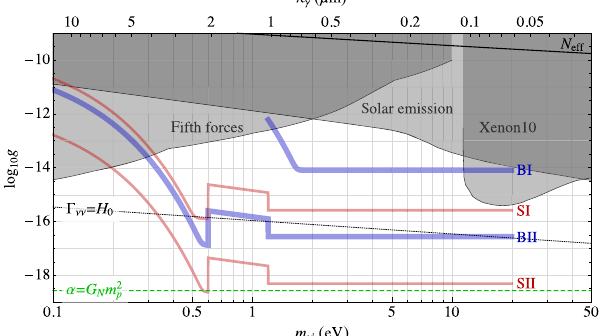
FIG. 9. Reach for the gauge coupling g of a B − L vector with mass m γ 0 . Gross sensitivity projections and exclusion regions are as in Fig. 8, with the addition of an exclusion region coming from searches for short-range fifth forces. We also indicate with the dashed green line the B − L gauge coupling that would yield a Coulomb force between nucleons with a strength equal to that of gravity, and with the dotted black line the gauge coupling below which the B − L vector is cosmologically stable against decays into three massless neutrino